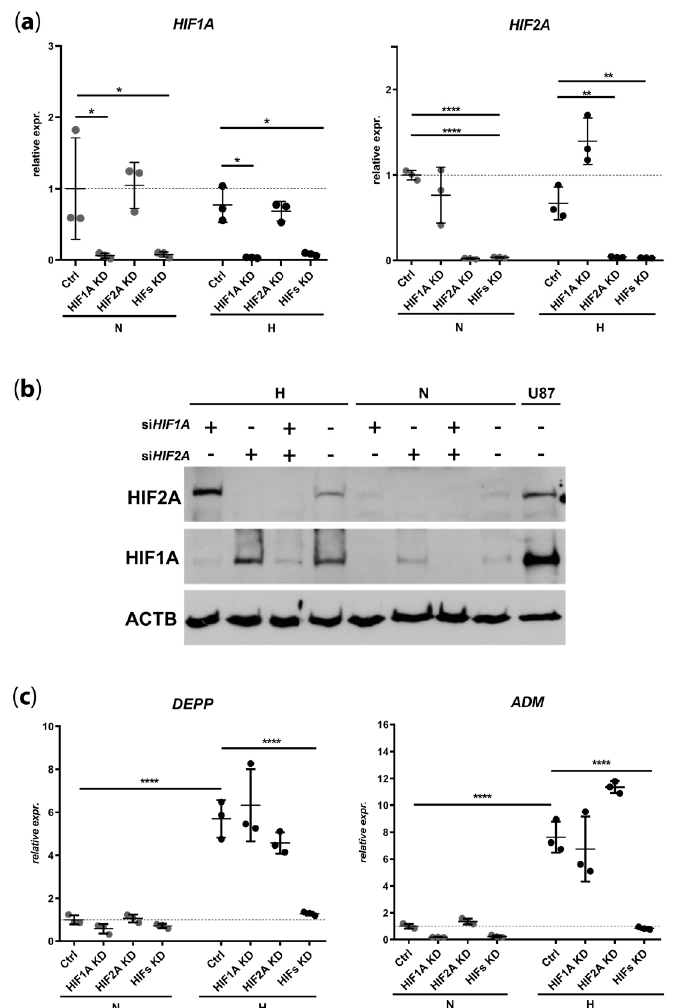
Figure 2. Loss of DEPP induction upon HIF1A and HIF2A knockdown in ARPE-19 cells. HIF1A and HIF2A ( a ), DEPP and ADM ( c ), transcript levels in normoxia ( N ) and hypoxia (H) were determined by real-time PCR in presence of HIF1A siRNA (HIF1A KD), HIF2A siRNA (HIF2A KD), or both HIF1A and HIF2A siRNAs (HIFs KD). Data are shown as fold changes over normoxic (N) siCTRL (Ctrl). ( b ) HIF1A and HIF2A protein levels in cells treated with siRNAs as indicated. Beta Actin (ACTB) served as loading control. Normoxic U87 neuroblastoma cells were used as positive control for HIF1A and HIF2A. Abbreviations see Figure 1. Shown are individual values and means ± SD of N = 3. Statistics: One-way ANOVA with Brown–Forsythe test, *: p ≤ 0.05, **: p ≤ 0.005, ***: p ≤ 0.005, ****: p ≤ 0.0005.